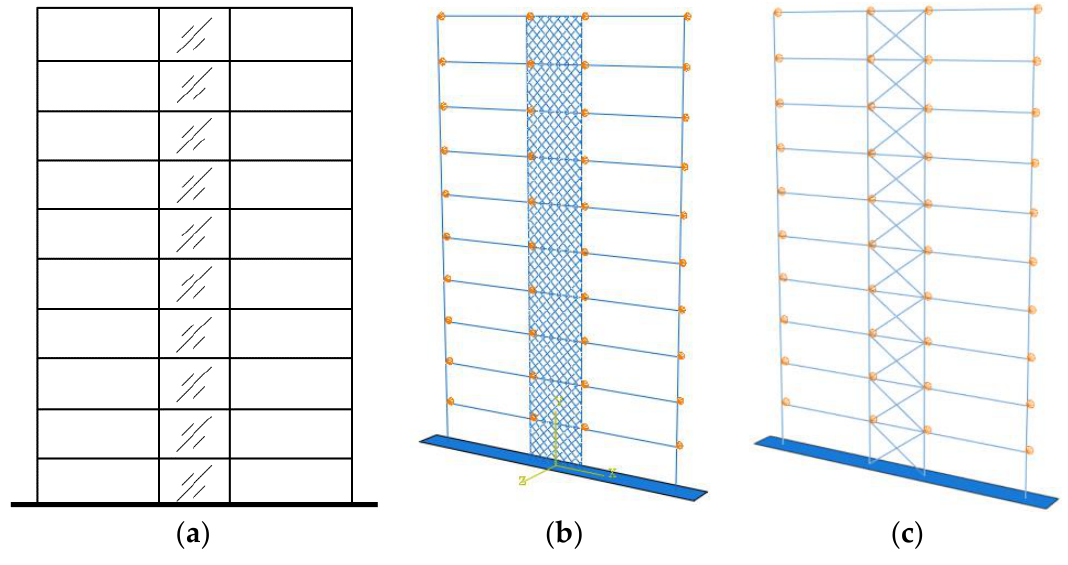
Figure 4. Finite Element Model: ( a ) the 3-span structure, ( b ) the SPSW model, and ( c ) the CoSPSW model.